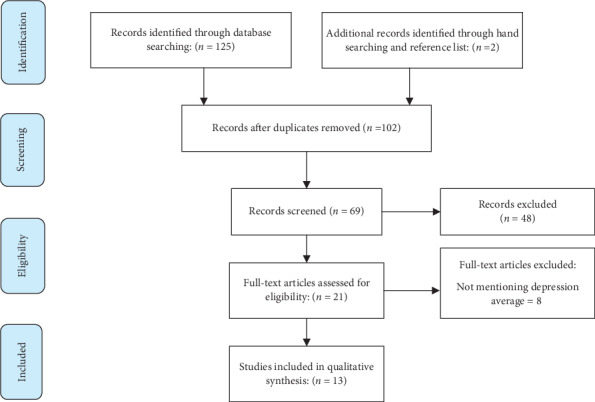
Flowchart of selection and review of articles based on the PRISMA statement.